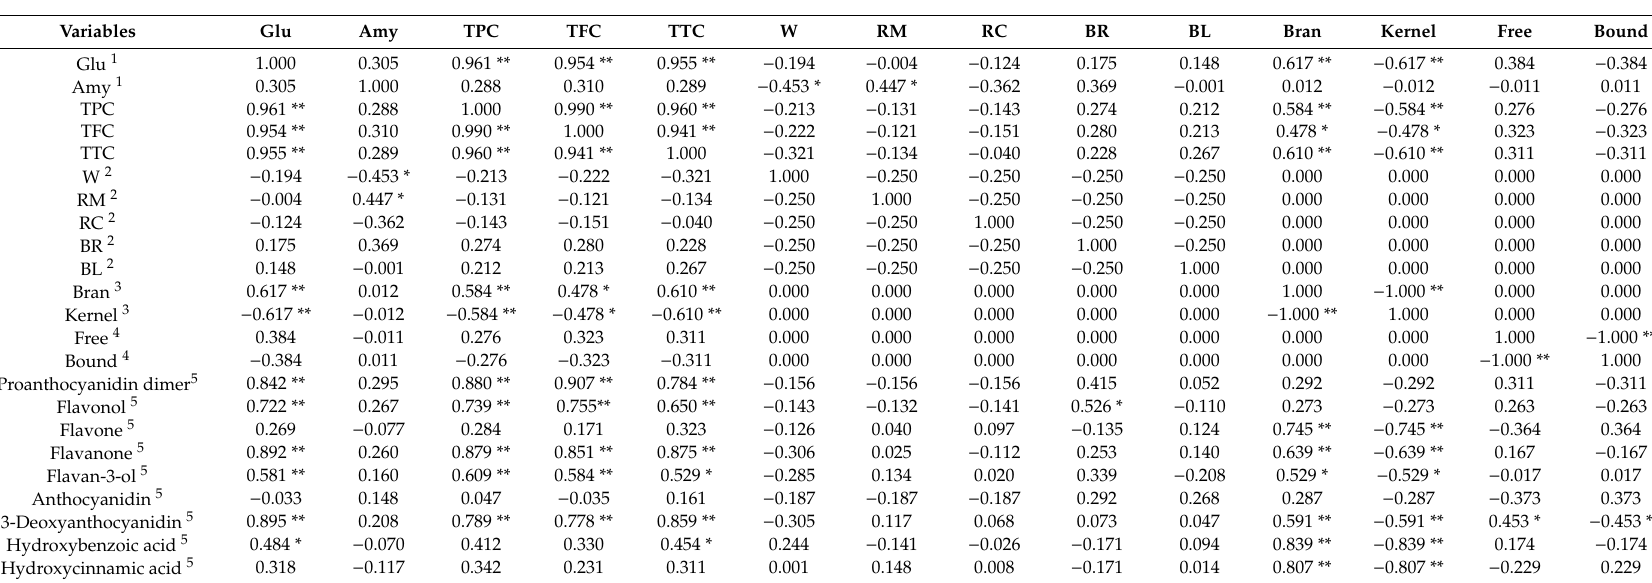
Table 2. Correlation coe ffi cient (r) between enzyme inhibitory activities, phenolic contents, sorghum genotypes, phenolic locations and phenolic form of